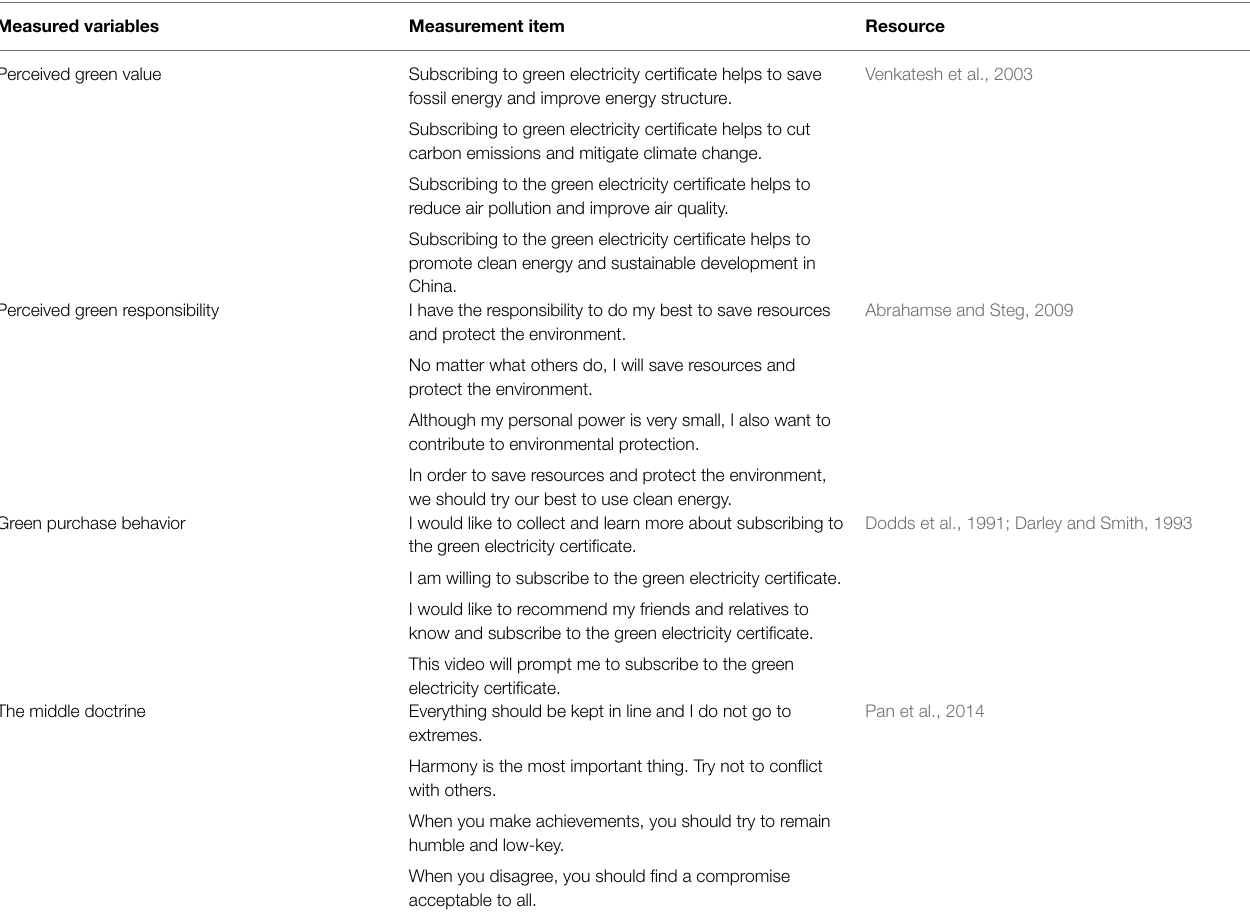
TABLE 1 | Measurement items of each